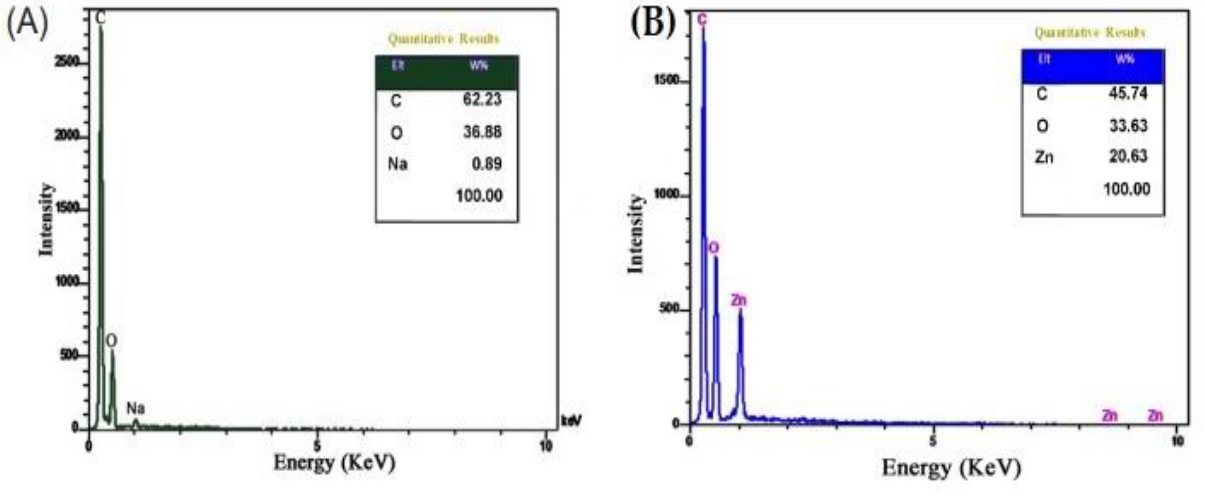
Figure 4. EDX analysis of (A) CMC, and (B)